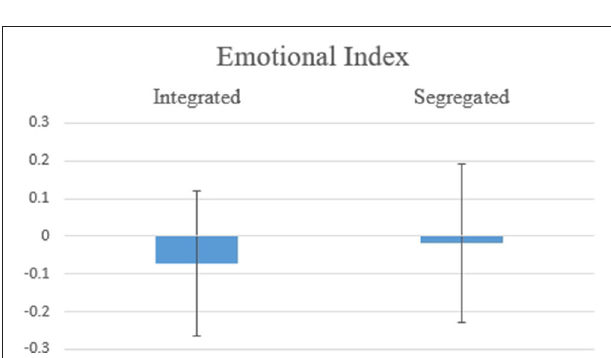
FIGURE 11 | Average values for the Emotional Index for BN/SP, two pieces of information Integrated vs. Segregated. The difference was statistically significant at F (1,13) = 4.871, p =